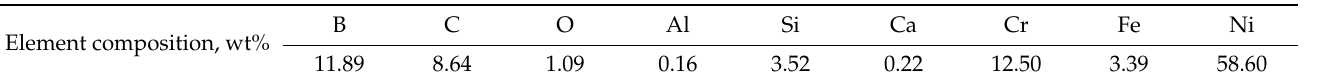
Table 4. Chemical composition of the NiB-Cr 7 C 3 coating.